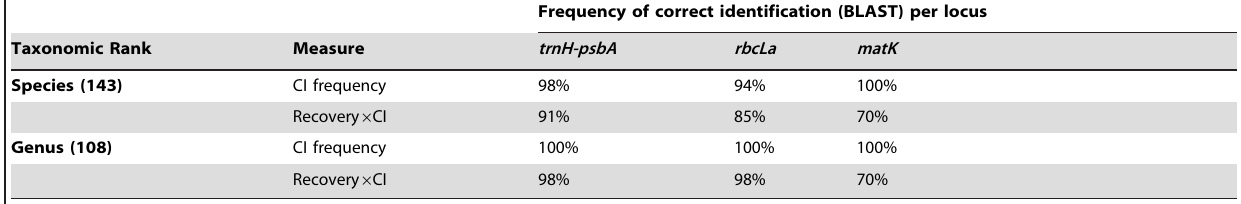
Table 2. BLAST results for frequency of correct identification (CI) for all species and